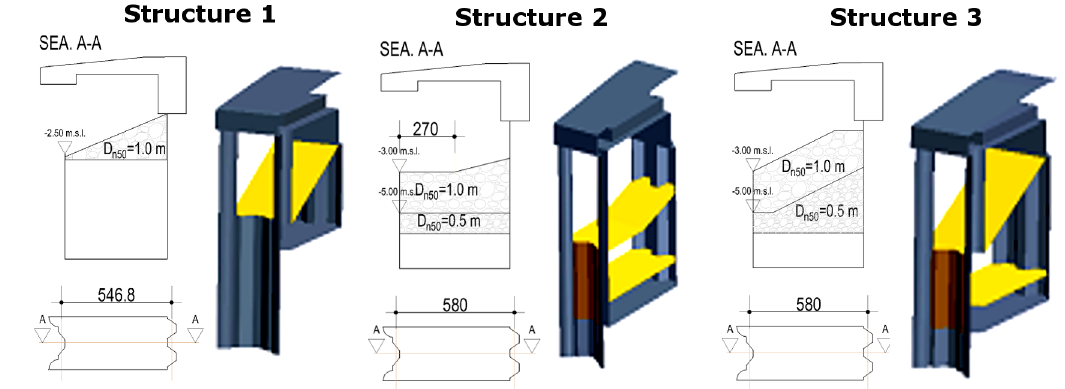
Figure 11. Simplified section and cad representation of the tested